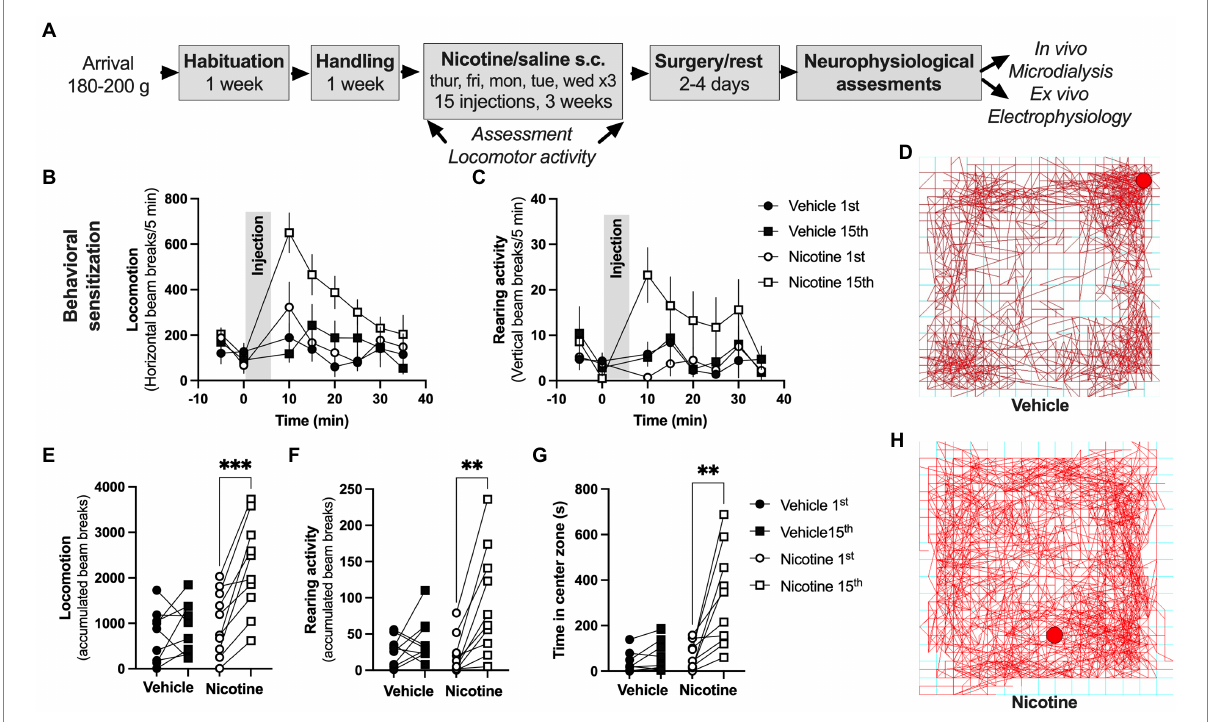
FIGURE 3 Repeated nicotine exposure produces behavioral sensitization in female rats. (A) Timeline for the described experiments. (B,C) Time-course graphs showing locomotor activity and rearing activity in response to nicotine injection. (D) Example picture showing ambulatory movement in a rat receiving vehicle injection. (E,F) Accumulated beam breaks elicited by either saline or nicotine exposure during the first and last injection demonstrated a selective increase in locomotion in rats receiving repeated nicotine injections. (G) Time spent in center zone was increased in response to repeated nicotine injections. (H) Example picture showing ambulatory movement in a rat receiving nicotine injection. Data are mean values ± SEM and based on 9–10 rats/treatment-group. * p < 0.05, ** p <